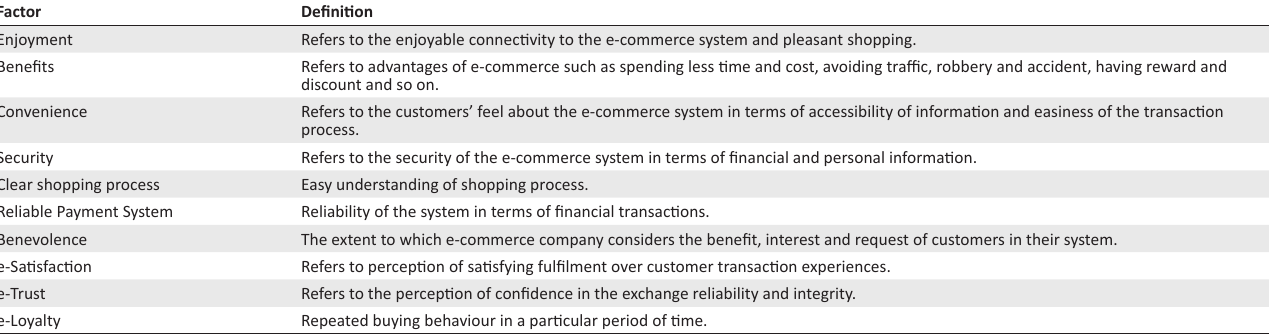
TABLE 1: Definition of effective factors in the research